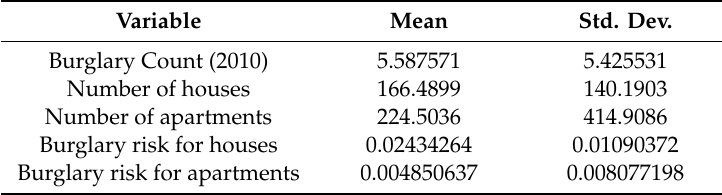
Table 4. Mean and standard deviation values for burglary risk and related